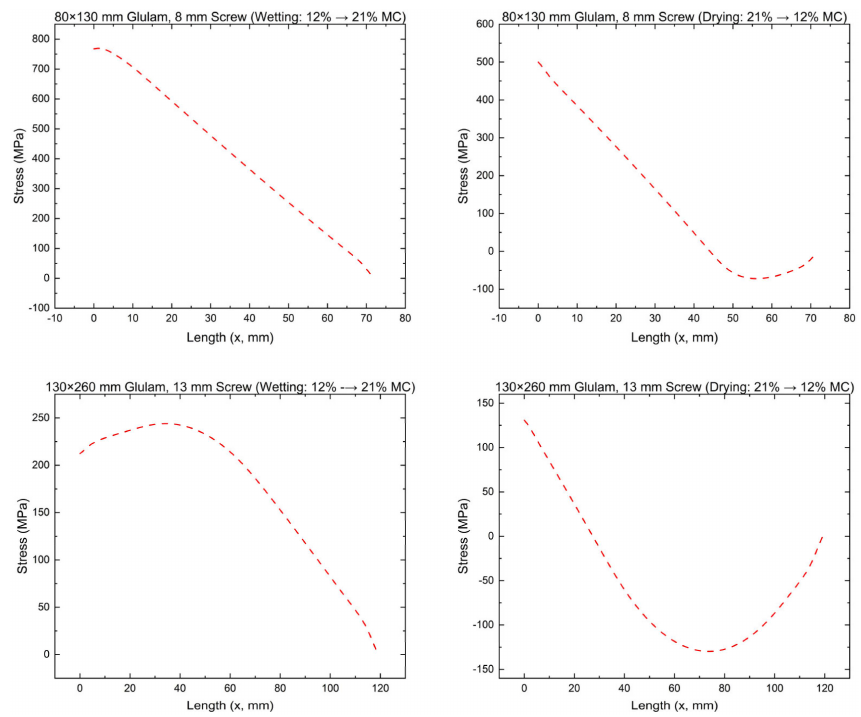
Figure 19. Screw axial stress distribution in